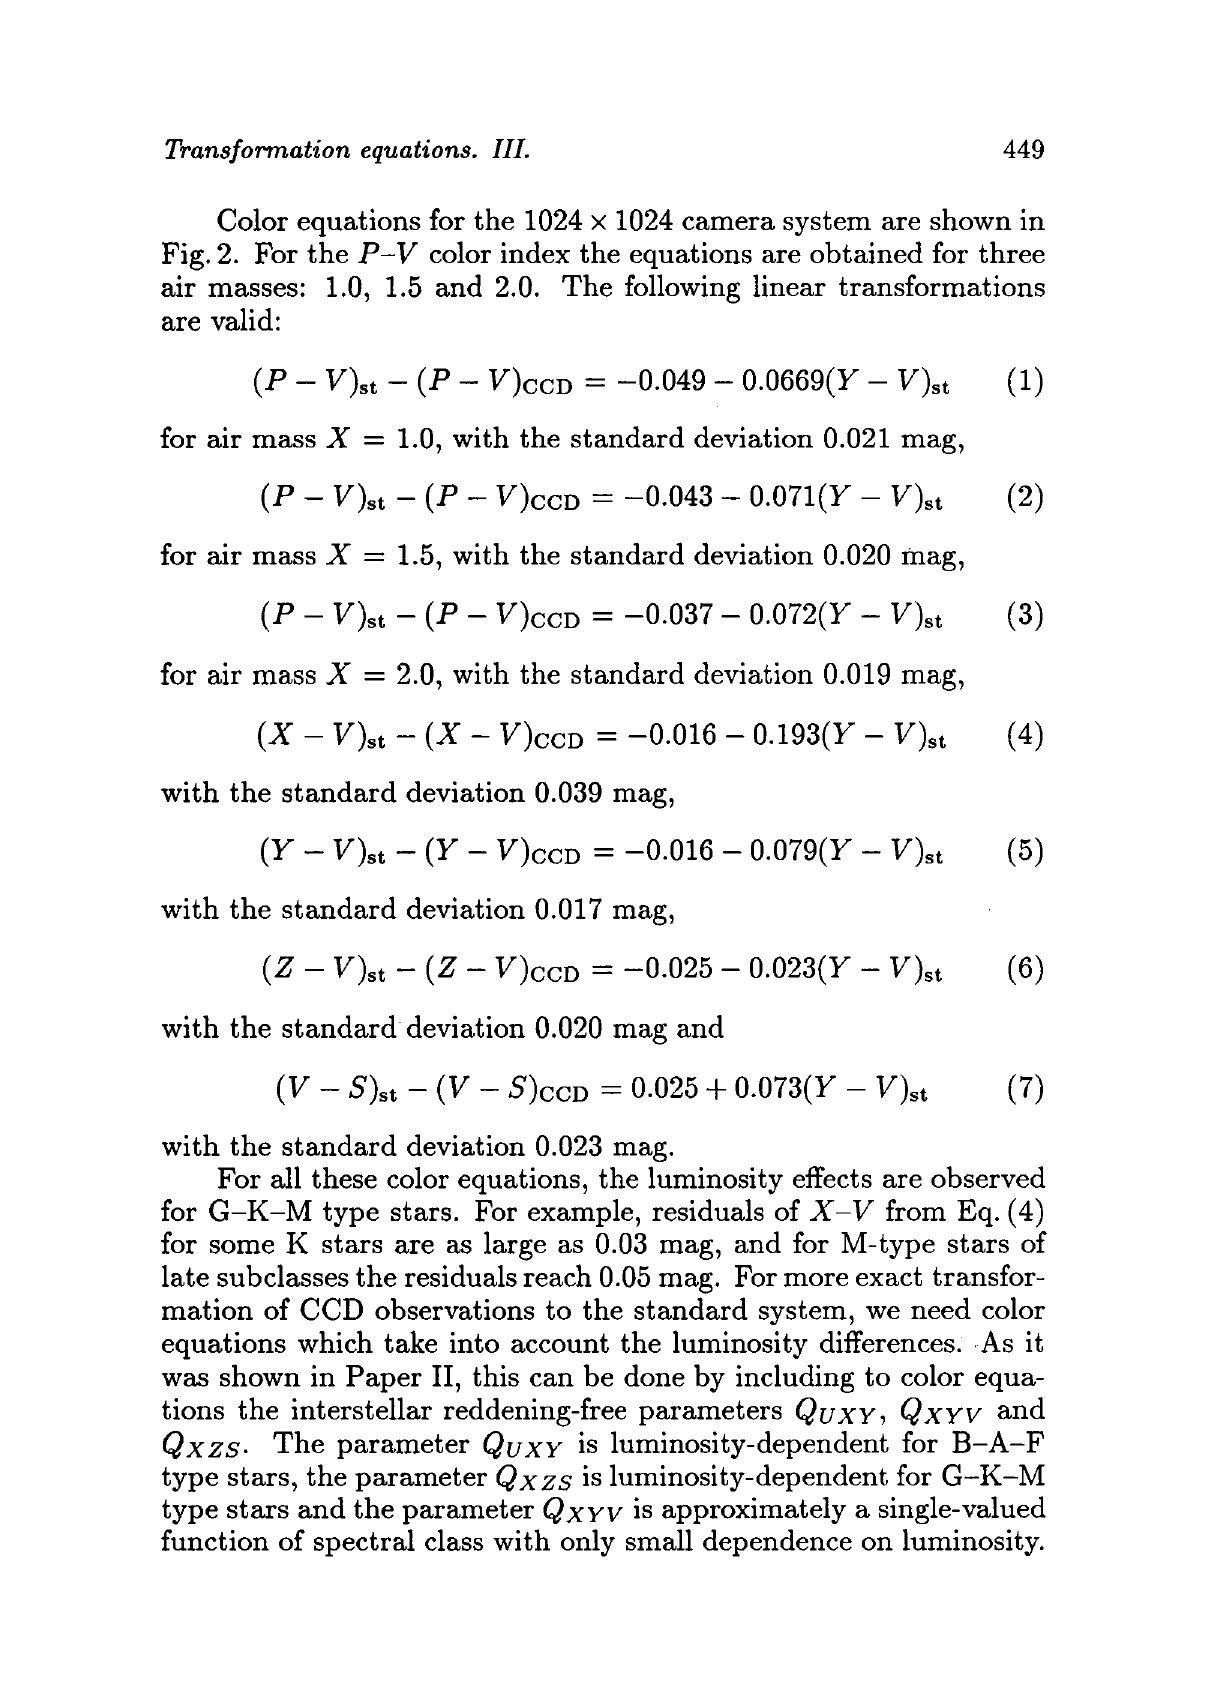
Color equations for the 1024 x 1024 camera system are shown in Fig. 2. For the P-V color index the equations are obtained for